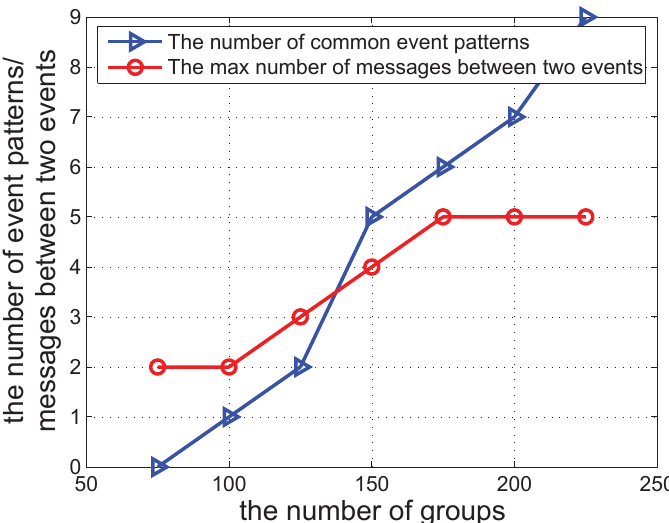
Figure 13. The number of common event patterns/the max number of messages between two events vs. the number of